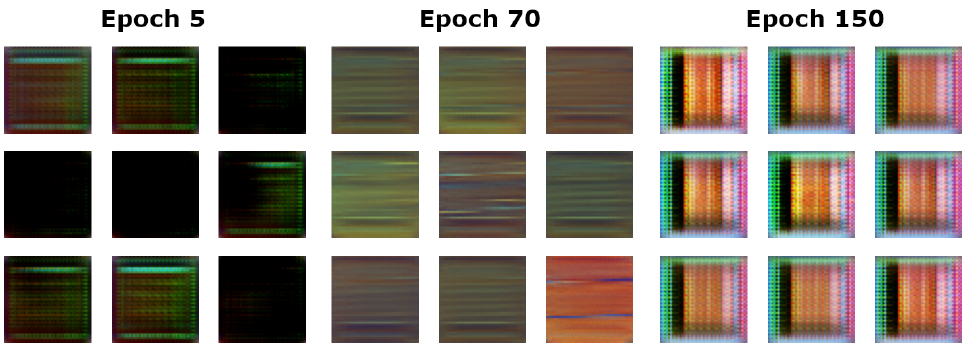
Figure 14. Evolution of the samples created using the RGB arrangement for three